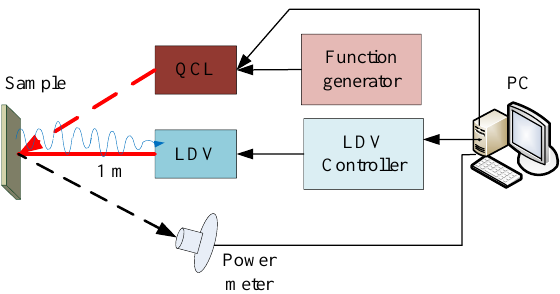
Figure 6. Schematic diagram of laser interferometer-based photoacoustic spectroscopy (PAS) sensor setup for the standoff detection of explosives at 1 m [151]. QCL, quantum cascade laser; LDV, laser Doppler vibrometer.